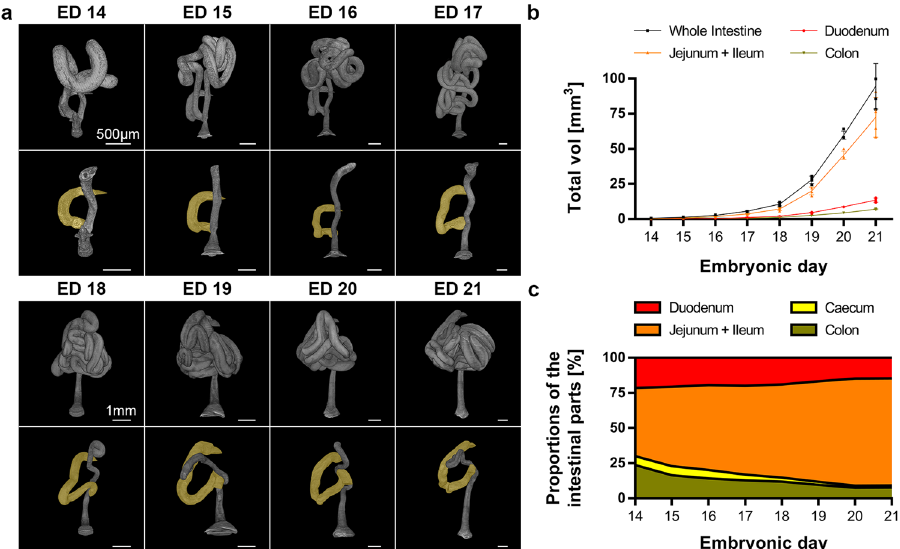
Fig. 6 Intestinal growth from ED 14 to ED 21. a Representative reconstructions of the whole intestine (upper row of each age) and of the separated duodenum (yellow) and colon (lower row of each age) are shown. While the small intestine shows an inconsistent looping, the morphology of the colon and the duodenum is preserved. The duodenal “ C ” is present in all age groups. b Volumes of all intestinal segments are shown over time as single data points with SD ( n = 4 animals). c The proportions of intestinal segments are shown over